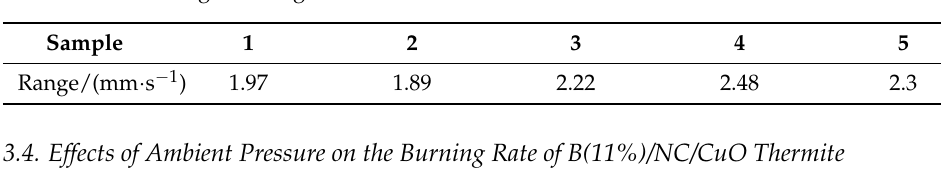
Table 4. The burning rate of B(11%)/NC/CuO thermite device.